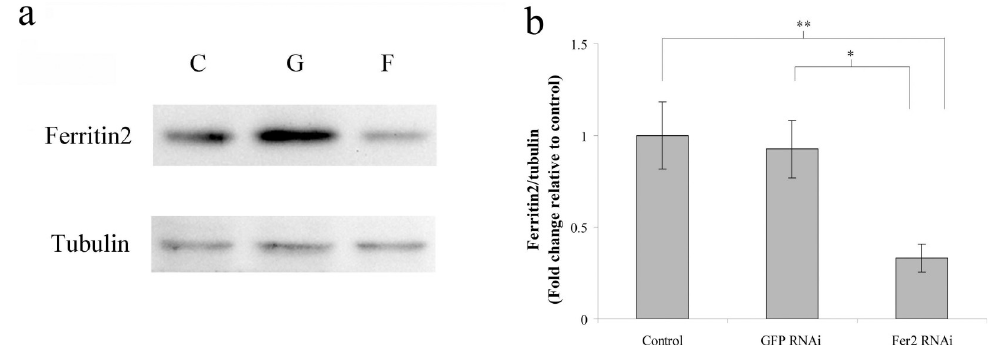
Fig 4. The protein levels of ferritin2 in trophocytes and oenocytes of worker bees at 20 days after feeding with ferritin2 dsRNA. ( a ) The protein levels of ferritin2. F, feeding with ferritin2 dsRNA. G, feeding with GFP dsRNA. C, feeding with water. Tubulin served as the loading control. ( b ) The results were normalized to the control and shown as fold changes, representing the mean ± SEMs ( n = 10). Fer2 RNAi, feeding with ferritin2 dsRNA. GFP RNAi, feeding with GFP dsRNA. Control, feeding with water. Asterisks indicate statistical significance ( � P < 0.05; �� P < 0.01; one-way